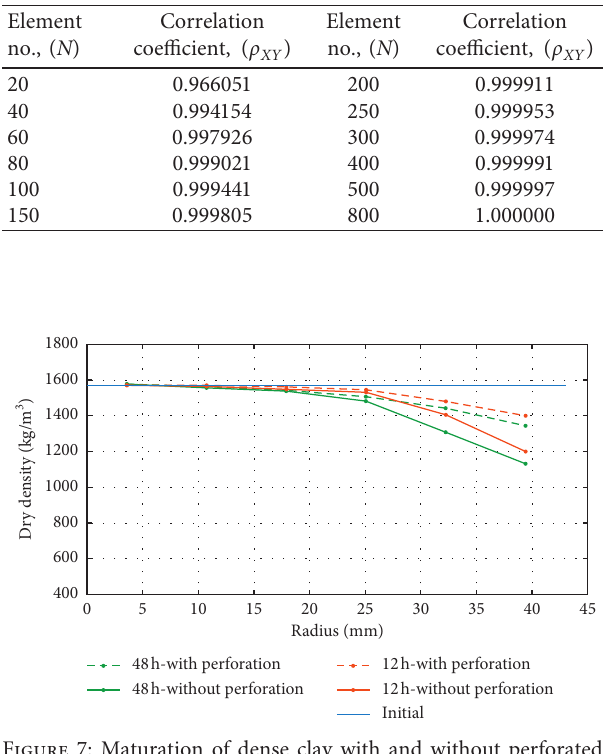
Table 1: Correlation coefficient values for multiple number of elements and 800 elements.